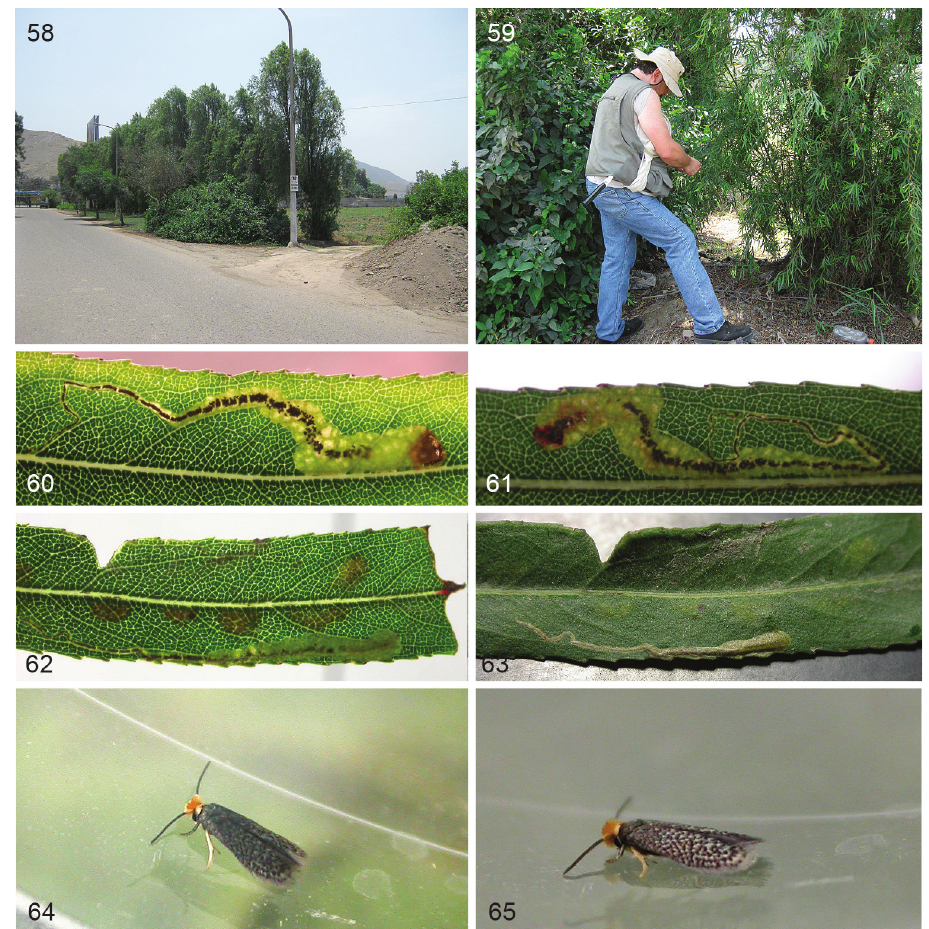
Figures 58–65. Stigmella molinensis , type locality Lima, Universidad Agraria la Molina, 240 m, host plant and life history. 58 Row of tall Salix humboldtiana trees, 9 December 2013 59 Chris Snyers, col- lecting leafmines in Salix humboldtiana , 16 December 2013 60–63 Vacated leafmines and leafmine with larva, 18 January 2010 64–65 Male, emerged 18 January 2010. cornuti in the phallus, whereas all other species have a reduced number of